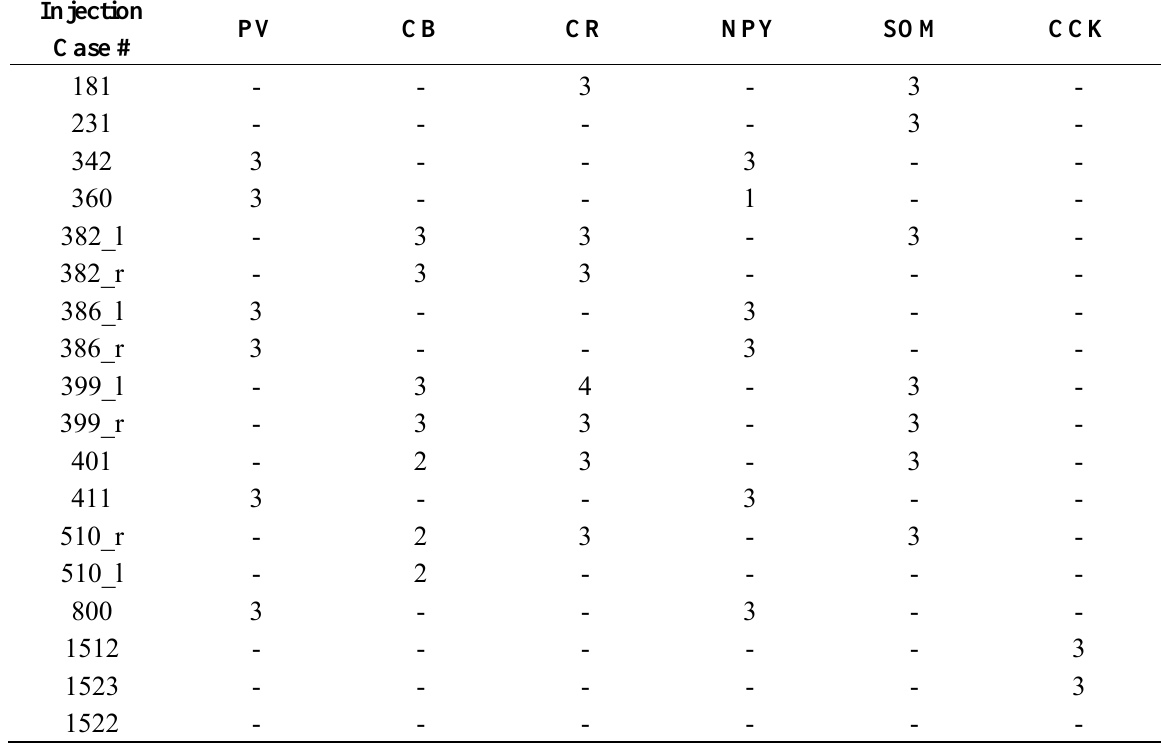
Table 1. List of injected animals, GABAergic markers, and number of sections analyzed.